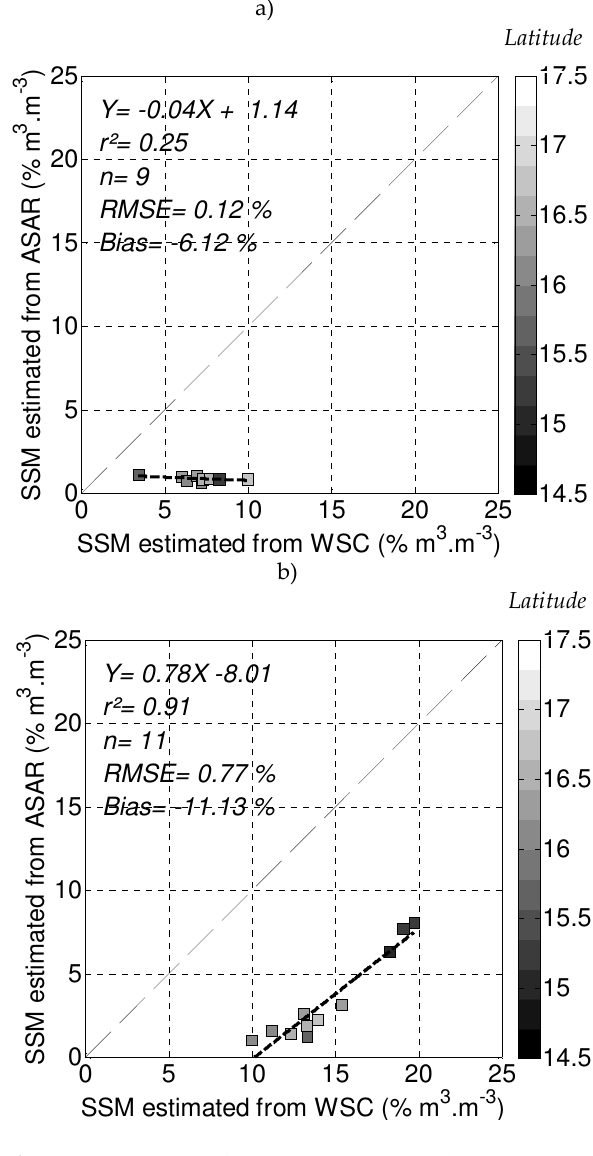
Fig. 12: Comparisons of SSM values estimated from ENVISAT- ASAR and ERS-WSC data for the 2005 driest (a) and wettest (b) dates (2005-09-08 and 2005-08-20, respectively). The location of SSM pixels versus the latitude is also indicated.